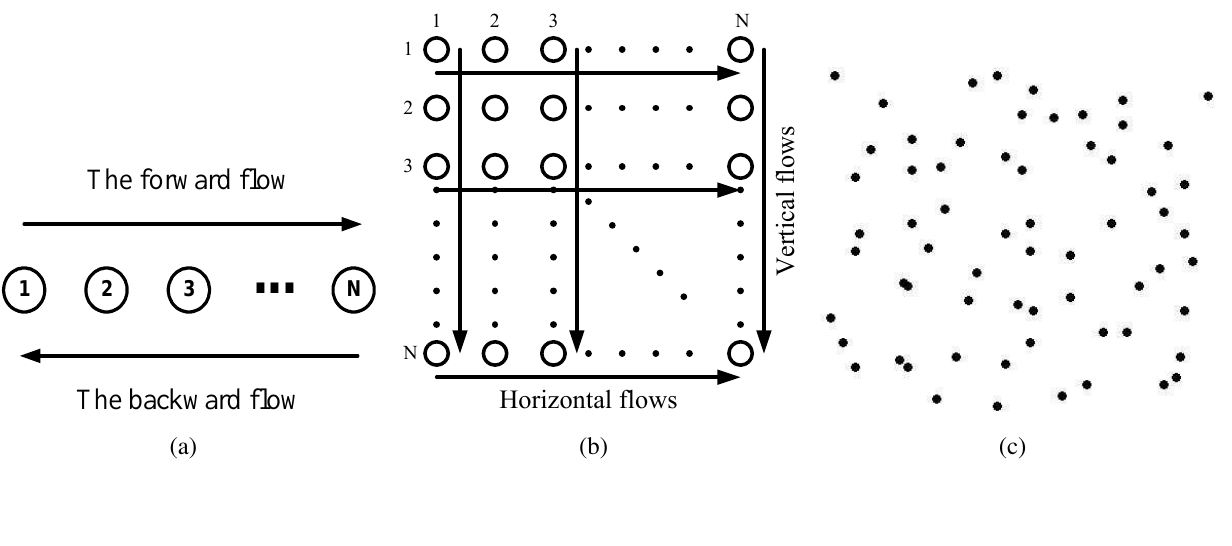
= 0 . 01 dB. (a) Throughput. dB